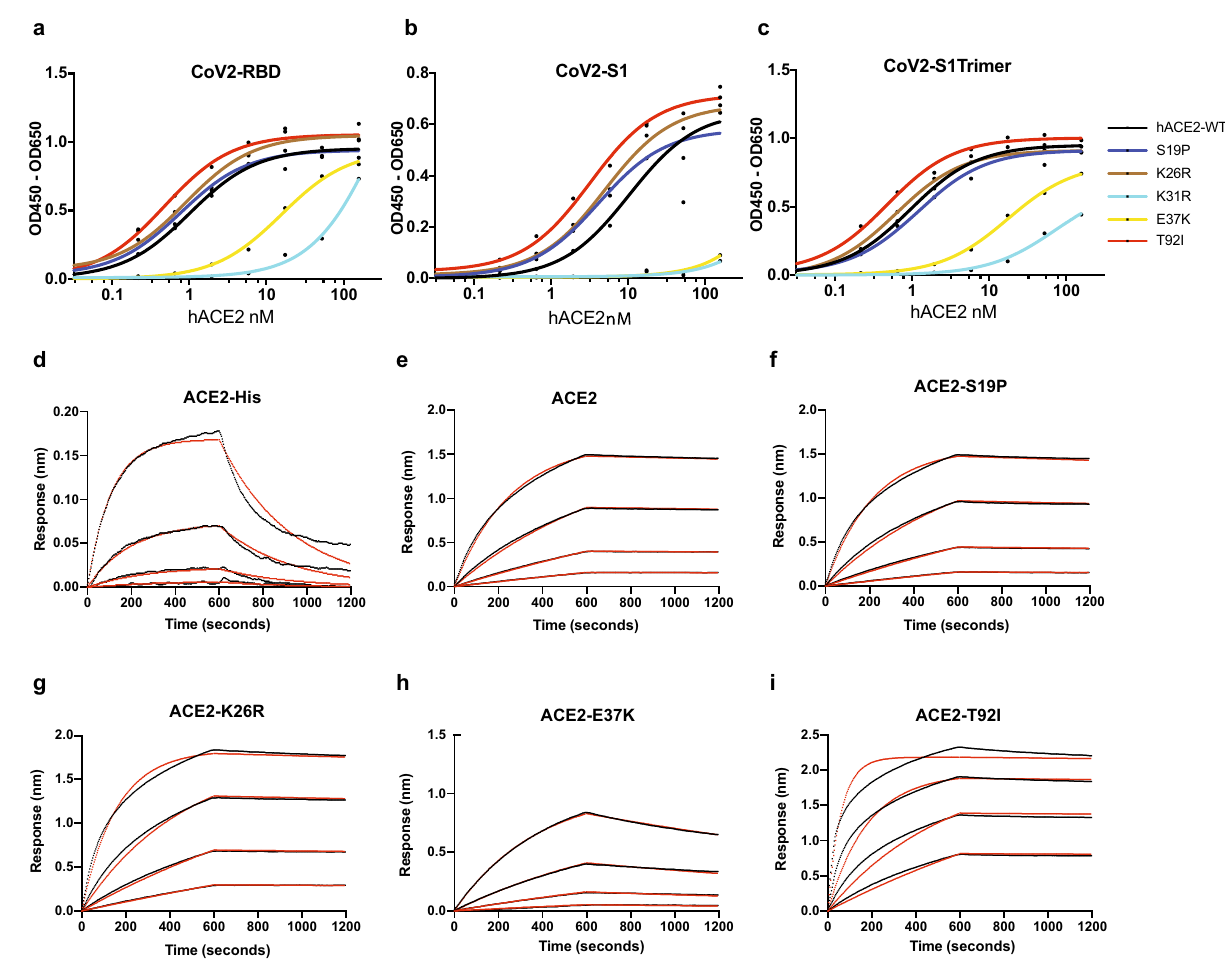
Fig. 4 Binding af fi nity of SARS-CoV-2 S-RBD, S1 and S-trimer. a – c ELISA assay measuring the af fi nity of indicated ACE2 WT or variants for SARS-CoV-2 S-RBD ( a ), S1 ( b ) and S-trimer ( c ). d – i Sensorgrams for the binding of a 3-fold dilution series of monomeric and dimeric ACE2 variants to streptavidin- captured SARS-CoV-2 RBD are provided (black). Fits to the empirical binding curves are shown overlaid